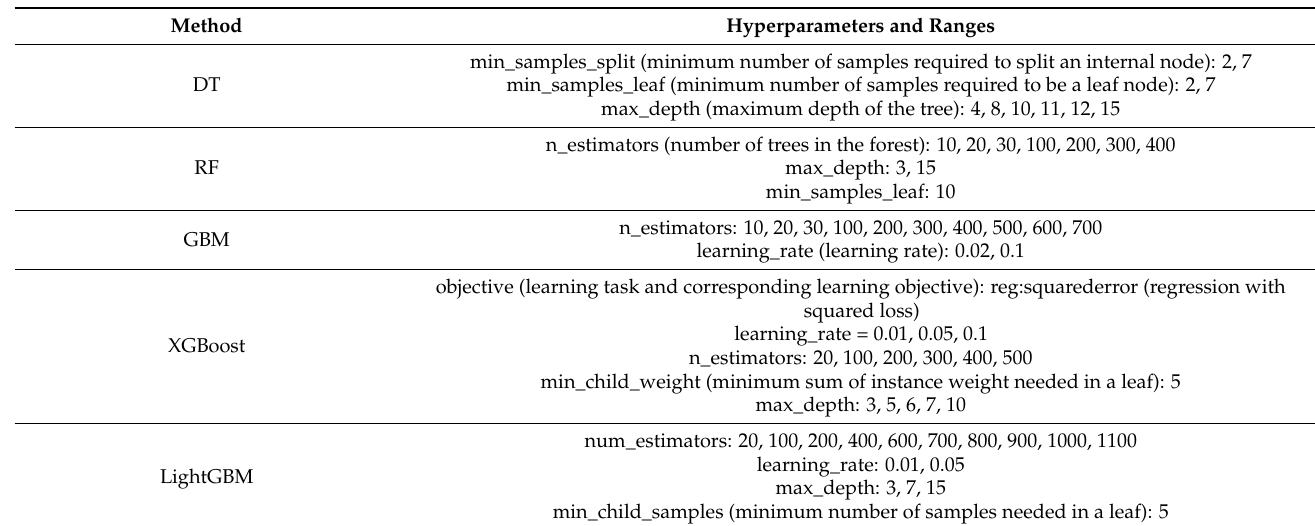
Table 7. Hyperparameters and ranges of decision-tree-based methods. Method Hyperparameters and